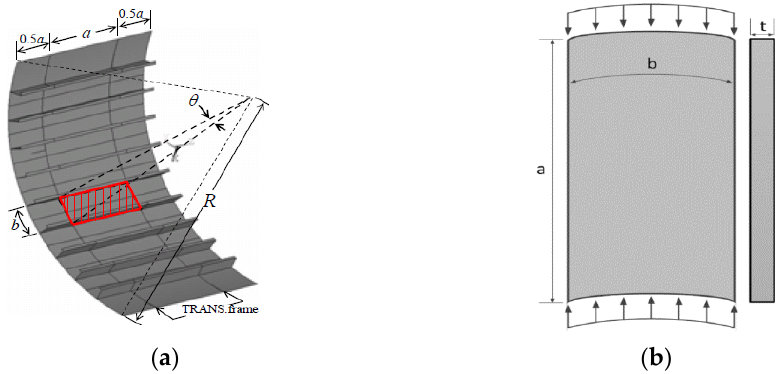
Figure 1. ( a ) Schematic of a cylindrically curved panel and ( b ) plate.